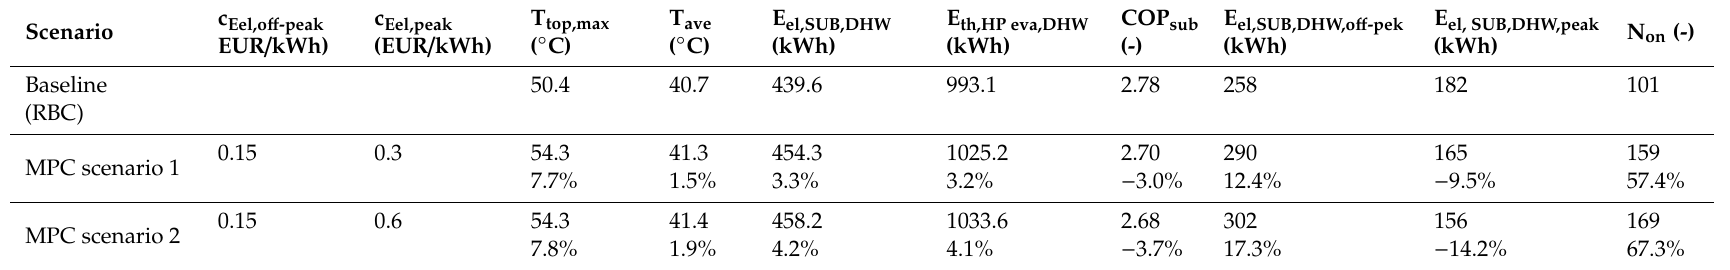
Table 2. Energy assessment of the scenario analysis. RBC: rule-based controller and MPC: model predictive control.